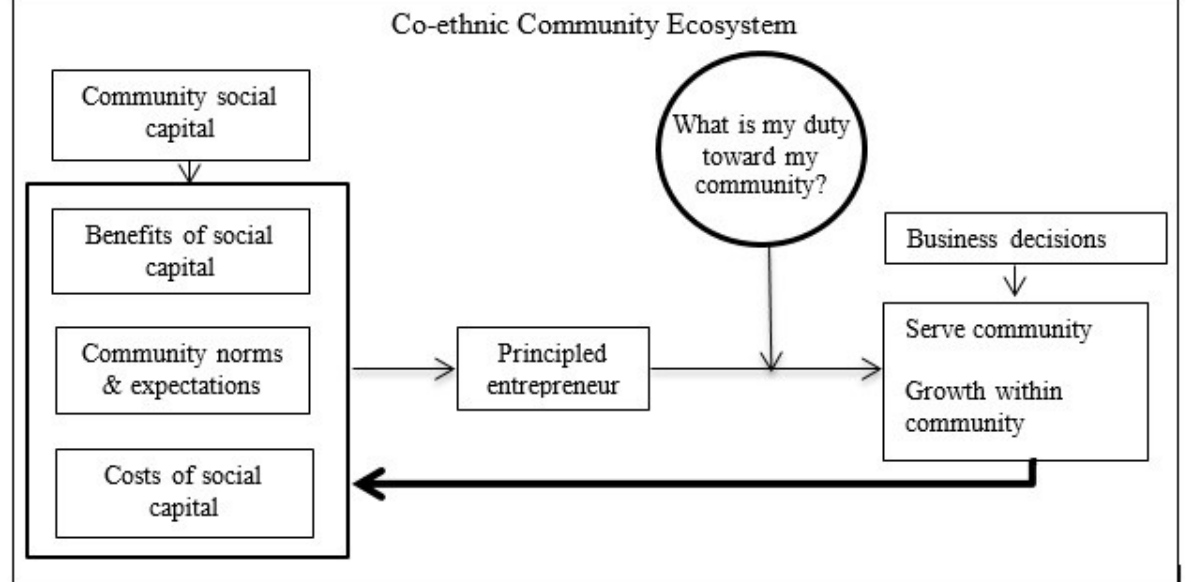
Figure. 1. Principled Entrepreneurs—Co-ethnic social capital and its impact on business